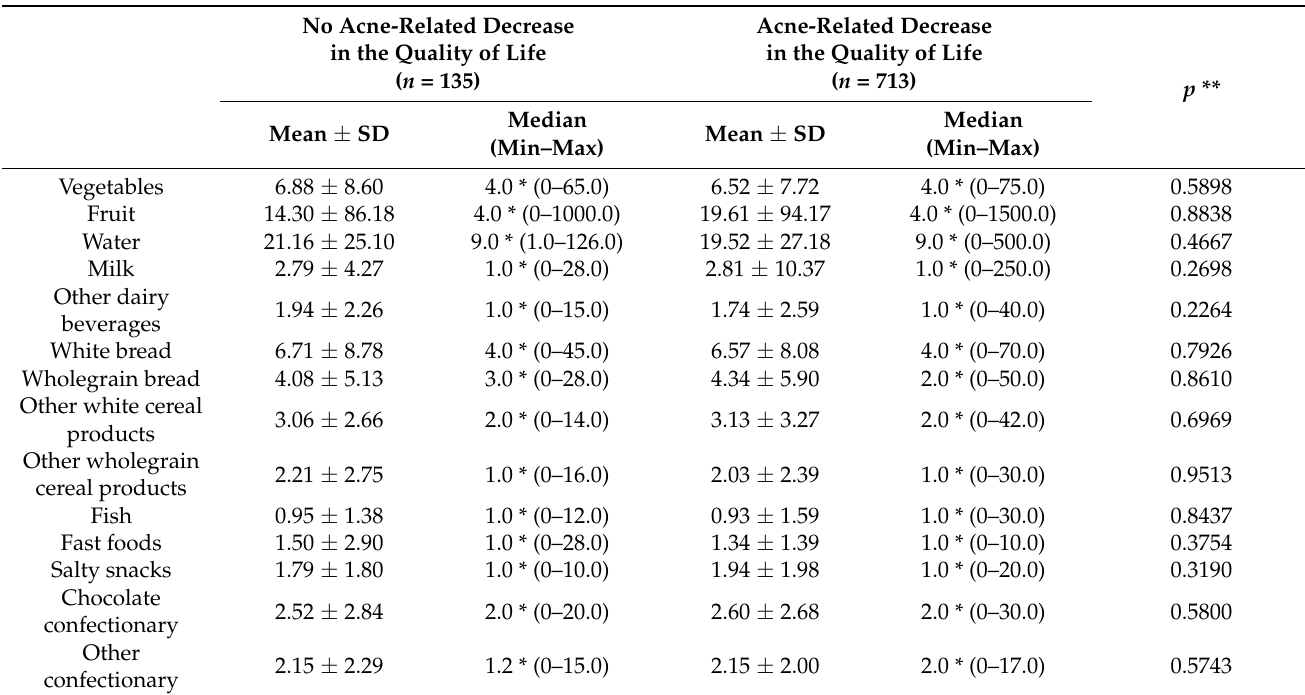
Table 7. The comparison of the consumption of food items within the Acne-specific Food Frequency Questionnaire (Acne-FFQ) in subgroups stratified by the acne-related quality of life, assessed based on the Acne Disability Questionnaire (ADQ) in the group of Polish female adolescents participating in the